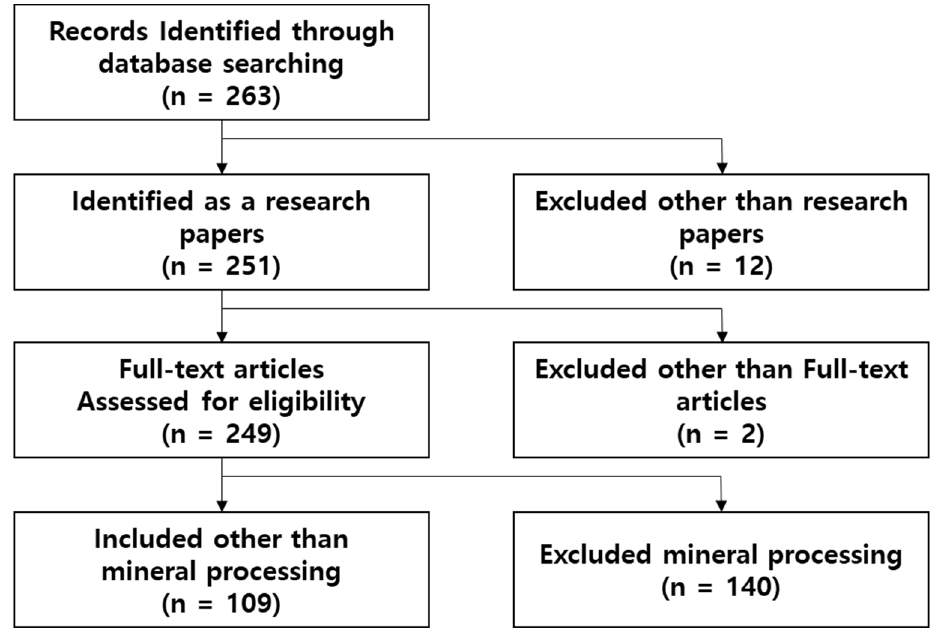
Figure 1. Flow chart of the selection process.